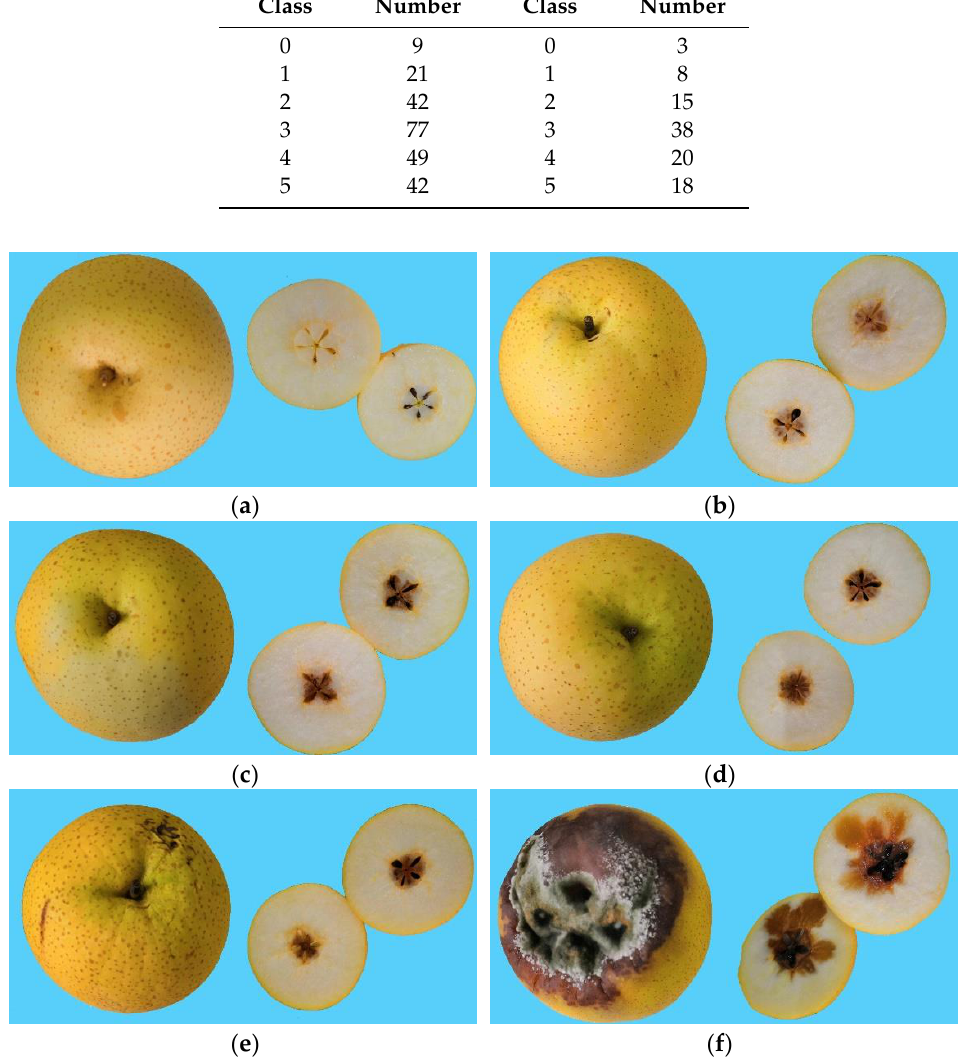
Figure 3. Photos of the Chinese pear (Huangguan) with different browning levels. Photos ( a – f ) indicates the levels of pear browning from class 0 to class 5, respectively.